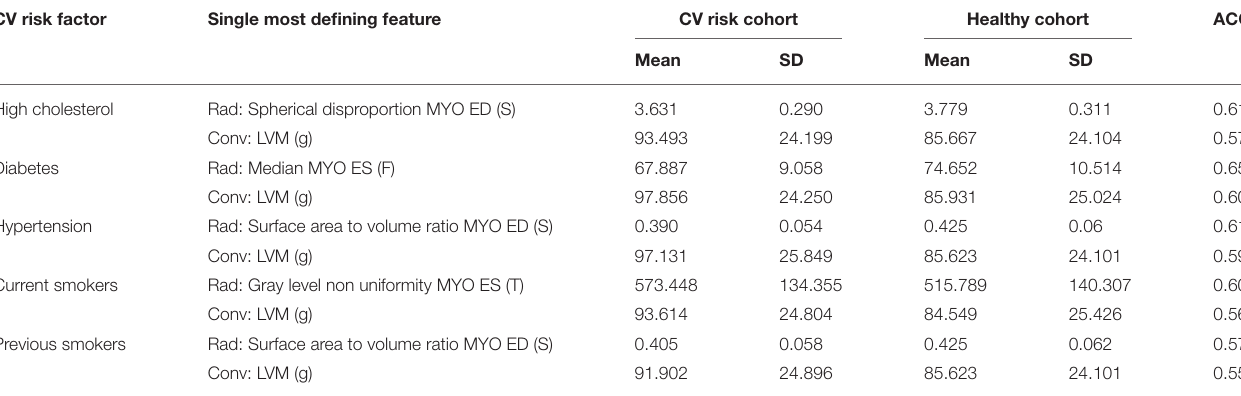
TABLE 3 | Values of the best radiomics features (Rad) and the conventional CMR indices (Conv). CV risk factor